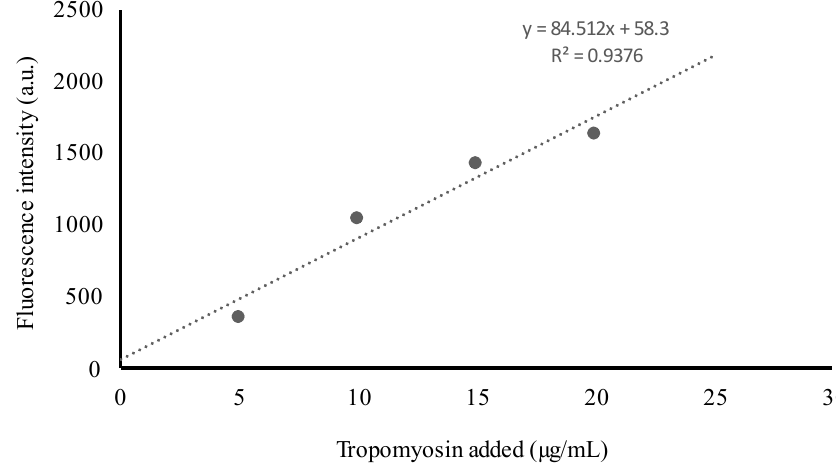
Figure 3. Calibration curve of standard addition of tropomyosin in a real sample .